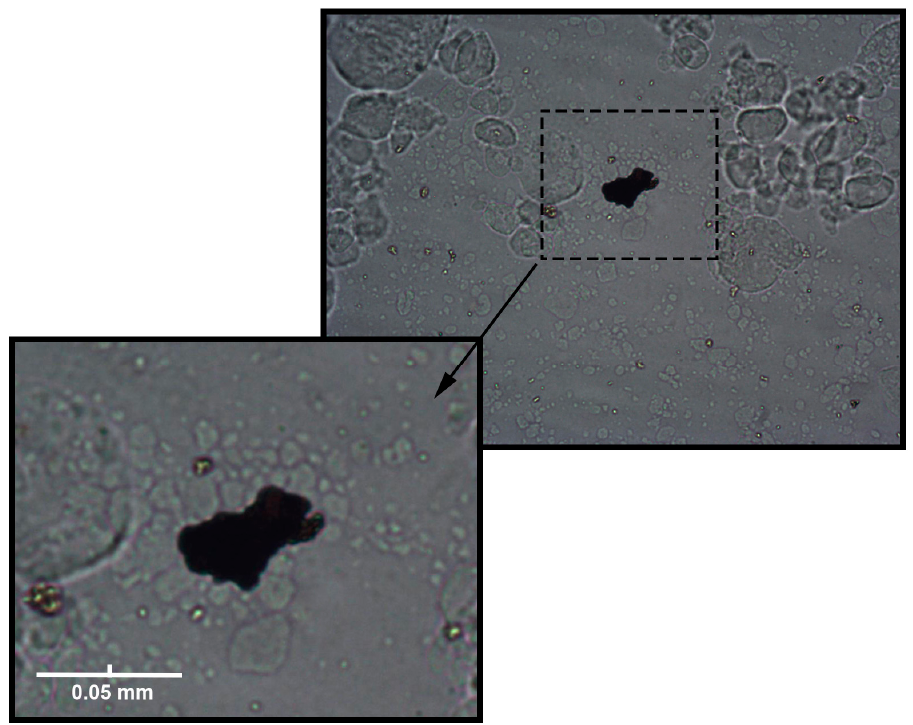
Figure 8. Magnified view of agglomerated and precipitated humic acid on the colloidal layer achieved under 10× g magnification of a light microscope.